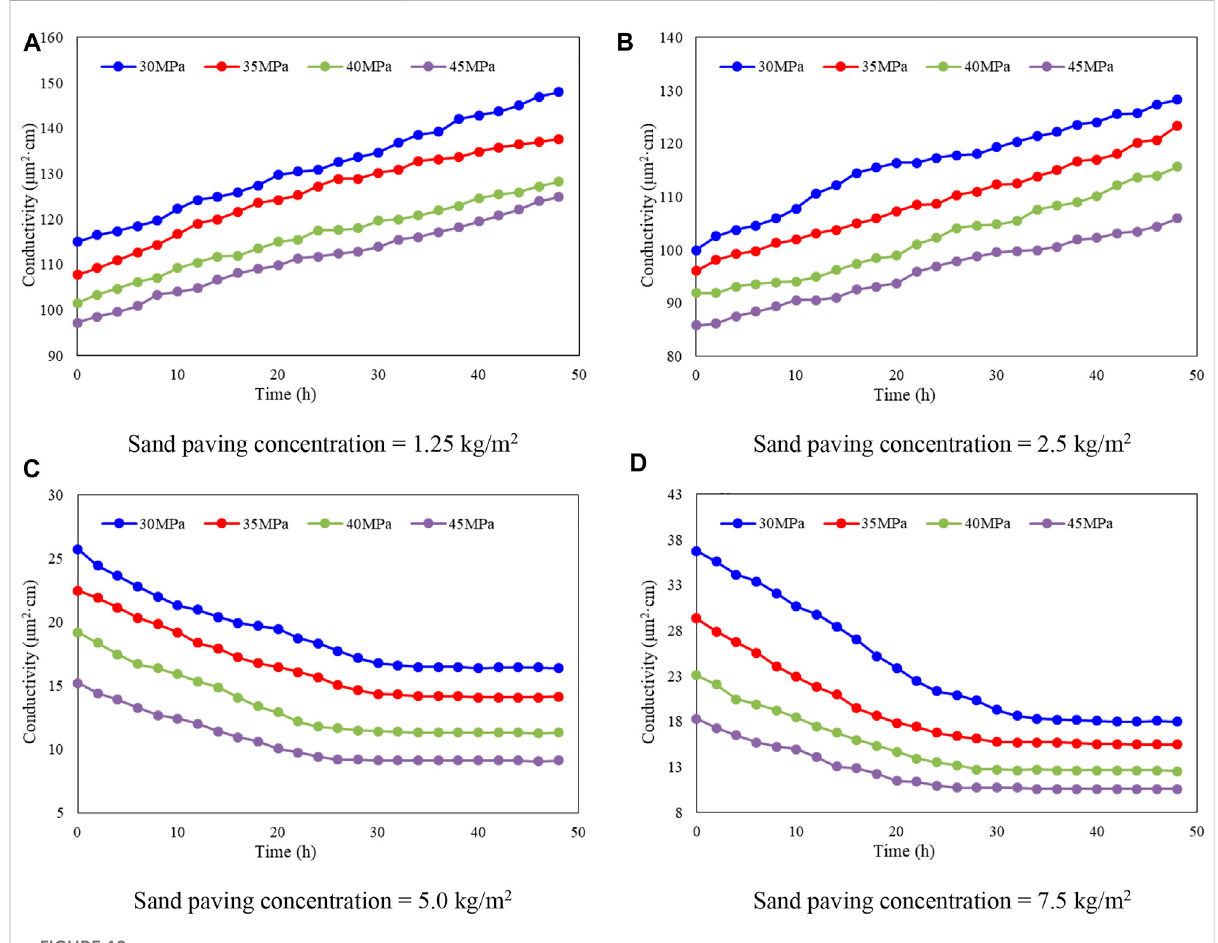
FIGURE 10 The proppant conductivity of CF 40 – 70 at different sand paving concentrations and different closure pressures.